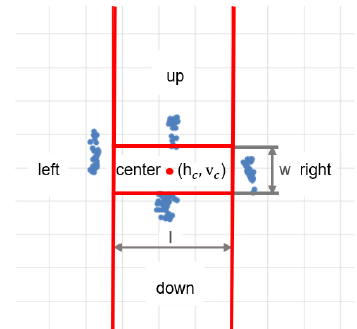
Figure 5. Visualization of the different functional zones on the GaVe display for one participant’s data during the pilot study. The blue points are the ratios recorded for four targets, and the red point is the horizontal and vertical ratio of the central point h c , v c after one-point